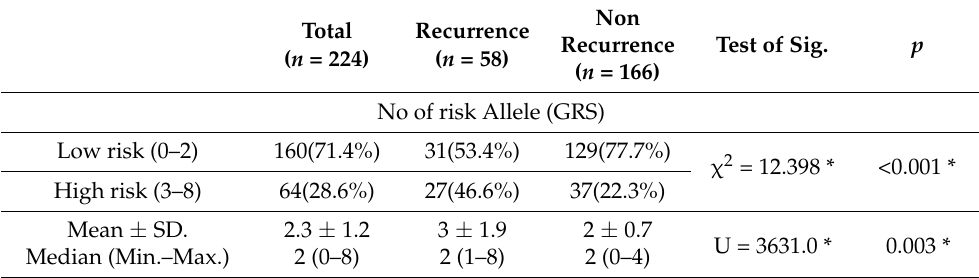
Table 4. Comparison between the two studied groups according to No of risk Allele (GRS).